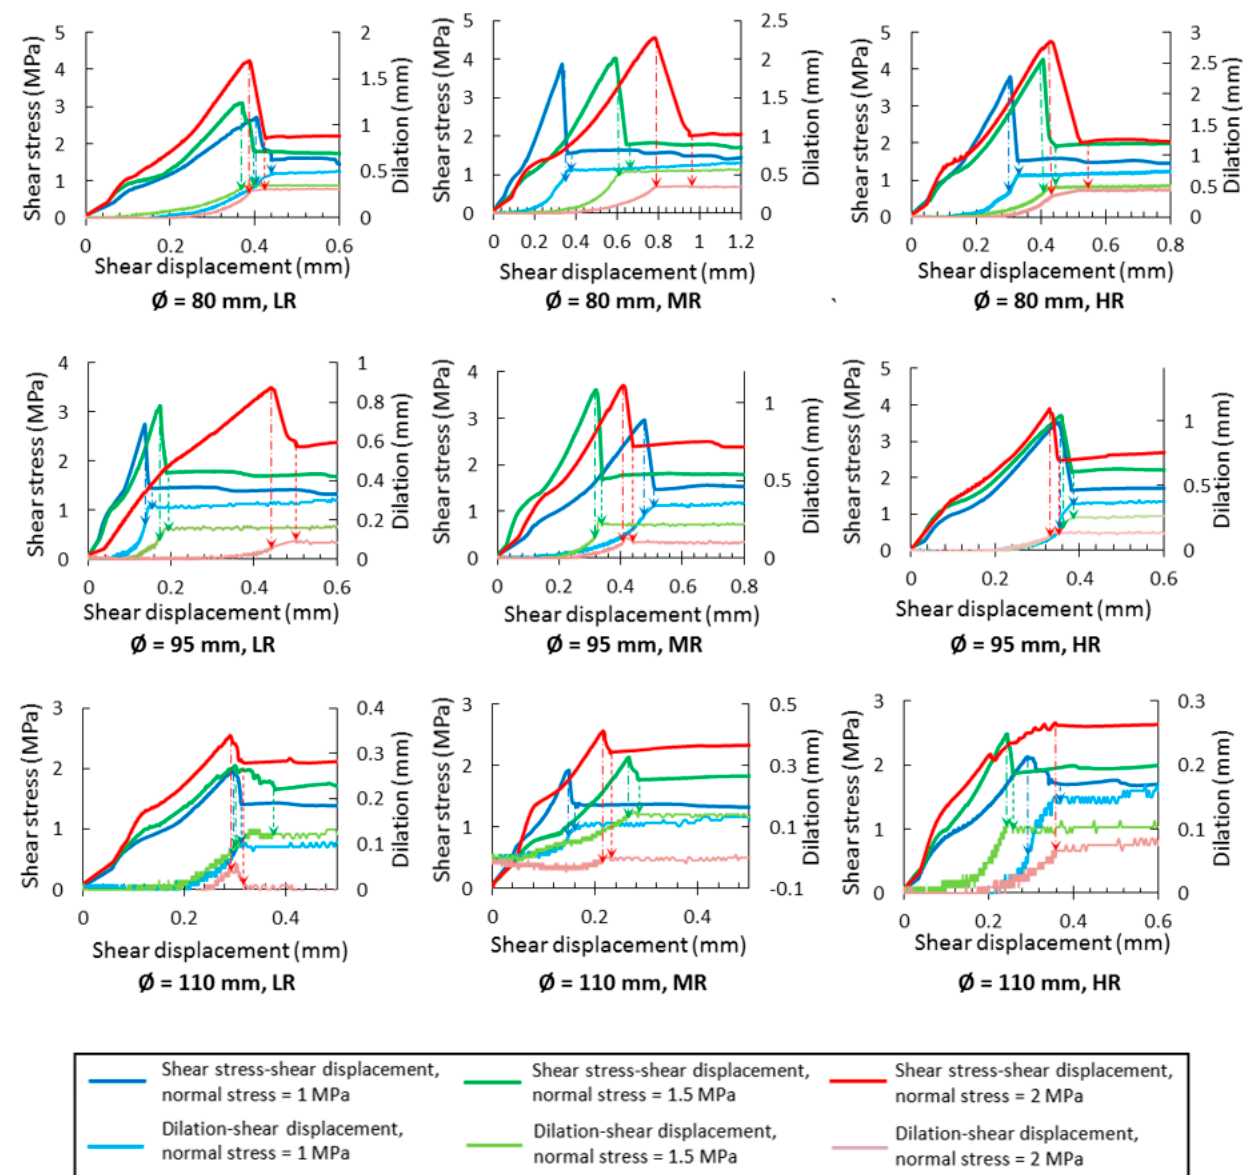
Figure 14. Dilation mechanism of J&Br specimens considering their shear stress–shear displacement curves. The rough jointed zone of the weakness planes causes dilation to a very limited extent while a J&Br specimen is sheared. However, a large portion of the peak dilation of the J&Br specimens (Figure 9) is expected to be caused by torque exerted due to the existing gap between the specimen holders. To investigate the cause of the dilation, the displacement field on one J&Br specimen ( Ø = 95 mm, HLR, 2 MPa) was analyzed using the DIC technique. Figure 15a illustrates the specimen on which some points whose vertical displacements are desired are marked. The central line in the figure depicts the